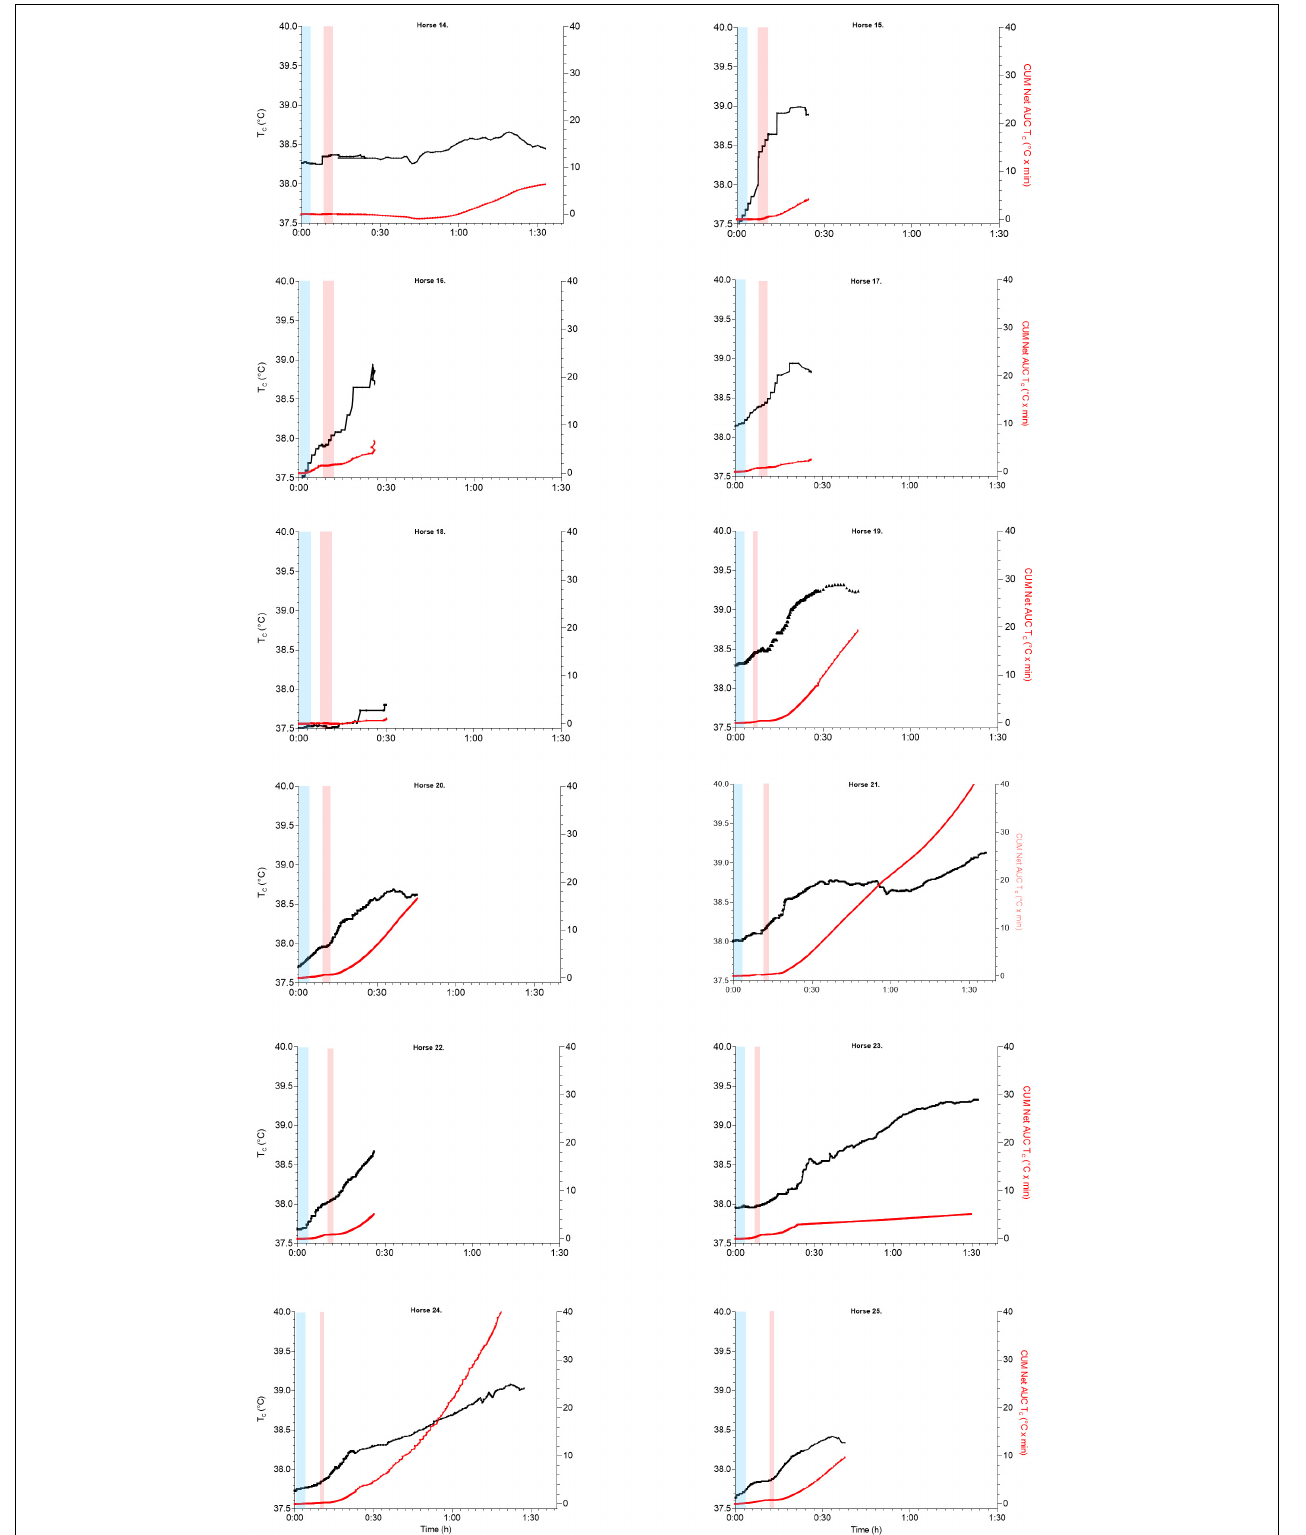
FIGURE 5 | Scatterplots of T c ( ◦ C; left y -axis, black line) and cumulated net AUC (T c , ◦ C × min; right y -axis, red line) over time (hours, h) during exercise and recovery in trotter horses H14–25, warm-up exercise (moderate intensity, identified as blue blocks), and trotter exercise (high intensity, identified as light-red blocks).